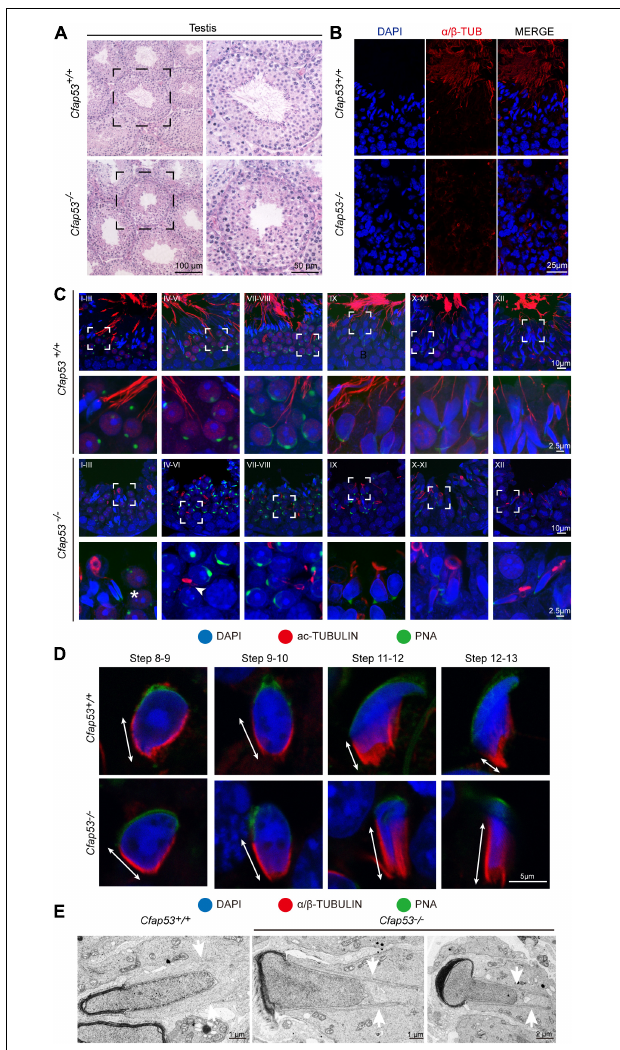
FIGURE 4 | Sperm flagellum biogenesis defects and abnormal manchettes in Cfap53 − / − mice. (A) H&E staining of testes sections from Cfap53 + / + and Cfap53 − / − male mice. (B) Immunofluorescence of anti- α / β -tubulin (red) antibodies in testes sections from Cfap53 − / − male mice show flagellar defects. (C) Comparison of flagellum biogenesis in testes sections from Cfap53 + / + and Cfap53 − / − mice at different stages. Sperm flagella were stained with anti-Acetylated tubulin (red), the acrosome was stained with PNA lectin histochemistry (green), and the nucleus was stained with DAPI (blue). Flagellum formation was first observed at stages I-III of the seminiferous epithelial cycle in Cfap53 + / + mice, while sperm tails were not detected (asterisks) at stages I-III in testes sections in Cfap53 − / − mice. From stages IV–VI, sperm flagellum biogenesis defects were clearly seen in Cfap53 − / − testis sections (arrowhead). (D) Comparison of manchette formation between Cfap53 + / + and Cfap53 − / − spermatids at different steps. The manchette was stained with anti- α / β -tubulin (red), the acrosome was stained with PNA lectin histochemistry (green), and the nucleus was stained with DAPI (blue). The distance from the perinuclear ring to the caudal side of the nucleus is indicated by white arrows. During steps 12 and 13, the distance was reduced in Cfap53 + / + spermatids, while the manchette of Cfap53 − / − spermatids displayed abnormal elongation. (E) Transmission electron microscope images of Cfap53 − / − step 11–13 spermatids showing the perinuclear ring constricting the sperm nucleus and causing abnormal sperm head formation. White arrows indicate the manchette